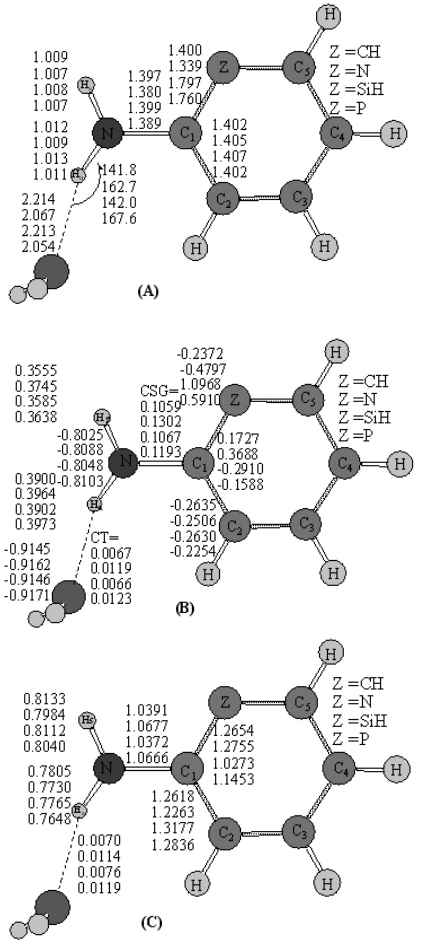
Figure 5. (A) MP2/cc-pVTZ optimized geometries of FAY(1)-HD (Y= C, N, Si, and P) complexes, with the bond lengths in angstroms. (B) MP2/6-311++G**//MP2/cc-pVTZ natural charges (in e) of partial charges, and the charge transfer (CT) from NH groups (CSG). (C) MP2/6-311++G**//MP2/cc-pVTZ